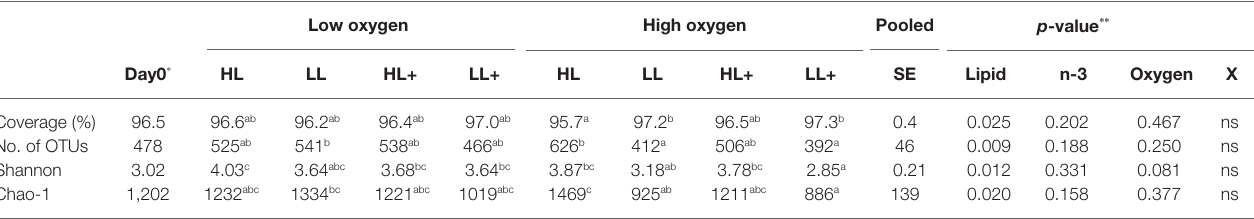
TABLE 1 | Alpha-diversity indices of intestinal bacteria from Atlantic salmon fed high lipid (HL) or low lipid (LL) with or without additional n-3 polyunsaturated fatty acids [PUFA (+)] for 0 ( N = 9) and 35 days ( N = 72) and reared at low and high oxygen. Low oxygen High oxygen Pooled p -value